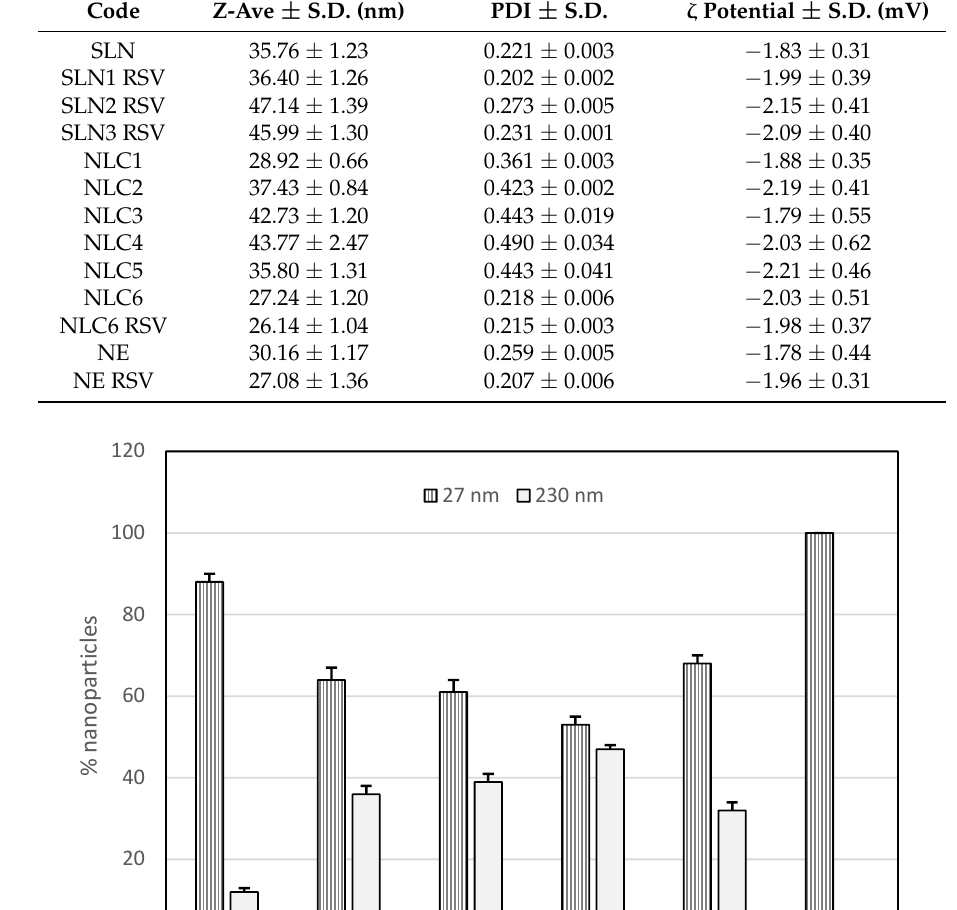
Table 2. Mean sizes (Z-Ave ± S.D.), polydispersity index (PDI ± S.D.) and ζ potential (±S.D.) of unloaded and RSV loaded lipid nano-carriers.